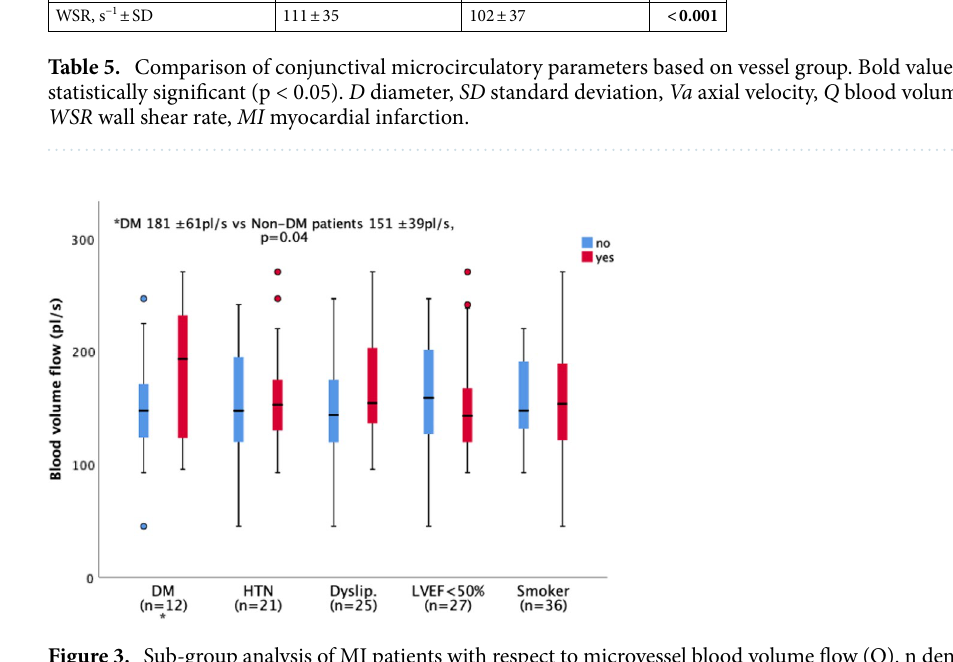
Figure 3. Sub-group analysis of MI patients with respect to microvessel blood volume flow (Q). n denotes the number of “yes” for each sub-group. DM diabetes mellitus, HTN hypertension, Dyslip. dyslipidaemia, LVEF < 50% left ventricular ejection fraction less than 50%, Smoker active smoker or ex-smoker vs no history